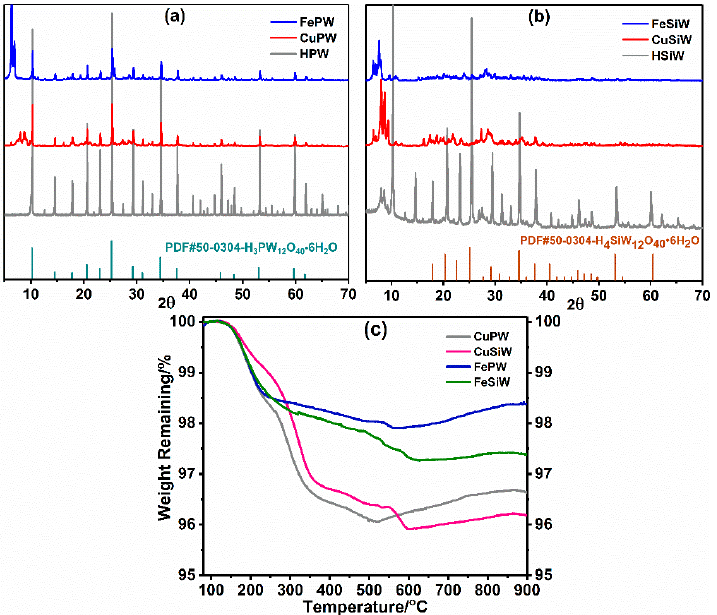
Figure 2. XRD patterns of the as-synthesized samples: ( a ) HPW, CuPW, FePW; ( b ) HSiW, CuSiW, FeSiW. ( c ) TG profiles of the as-synthesized samples (pre-treated at 120 ° C for 0.5 h).